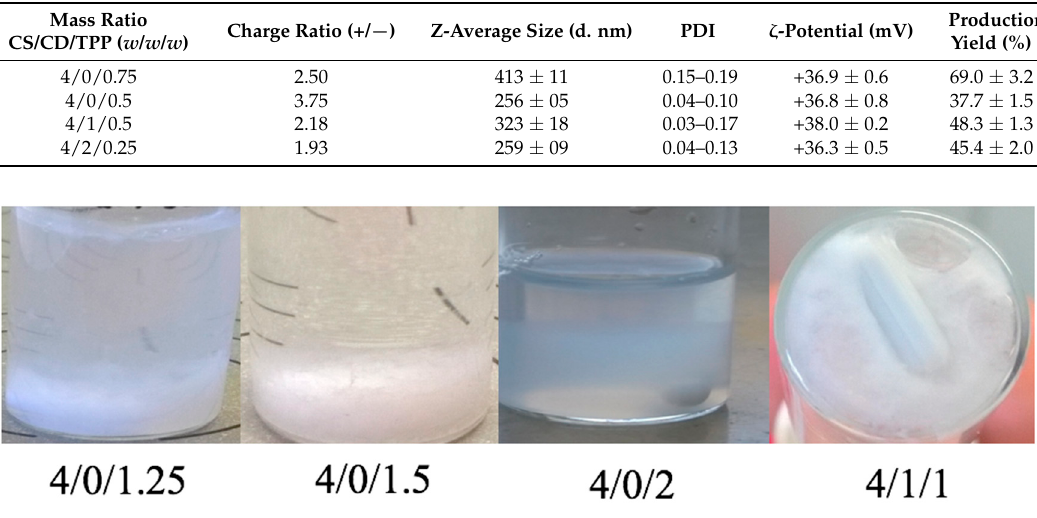
Figure 2. Appearance of various formulations of CS 70/20 /SBE β CD/TPP nanoparticles immediately after being prepared, showing the aggregation phenomenon. Table 2. Physicochemical properties of unloaded CS 70/20 /SBE β CD/TPP nanoparticles (mean ± S.D., n = 3).